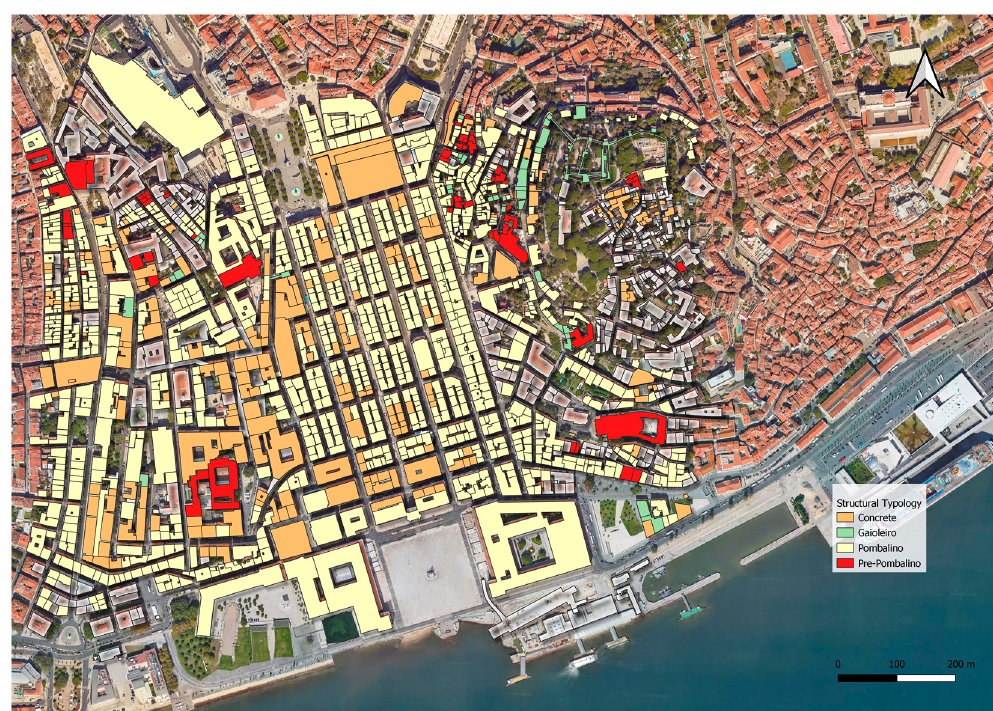
Figure 6. Construction typology of the buildings under study.